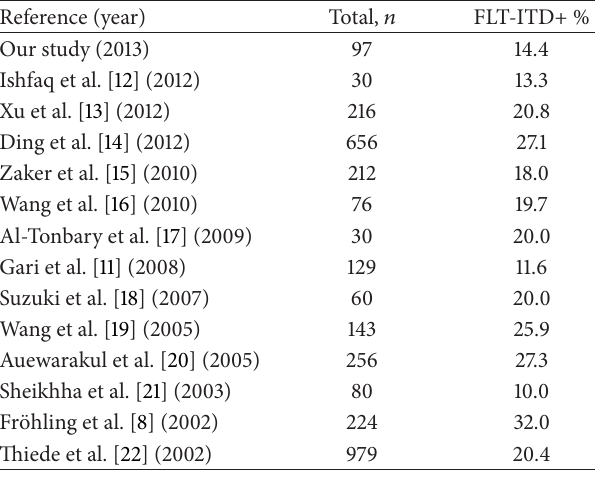
Table 2: Frequency of FLT3 /ITD mutations in the current study and in previous studies.